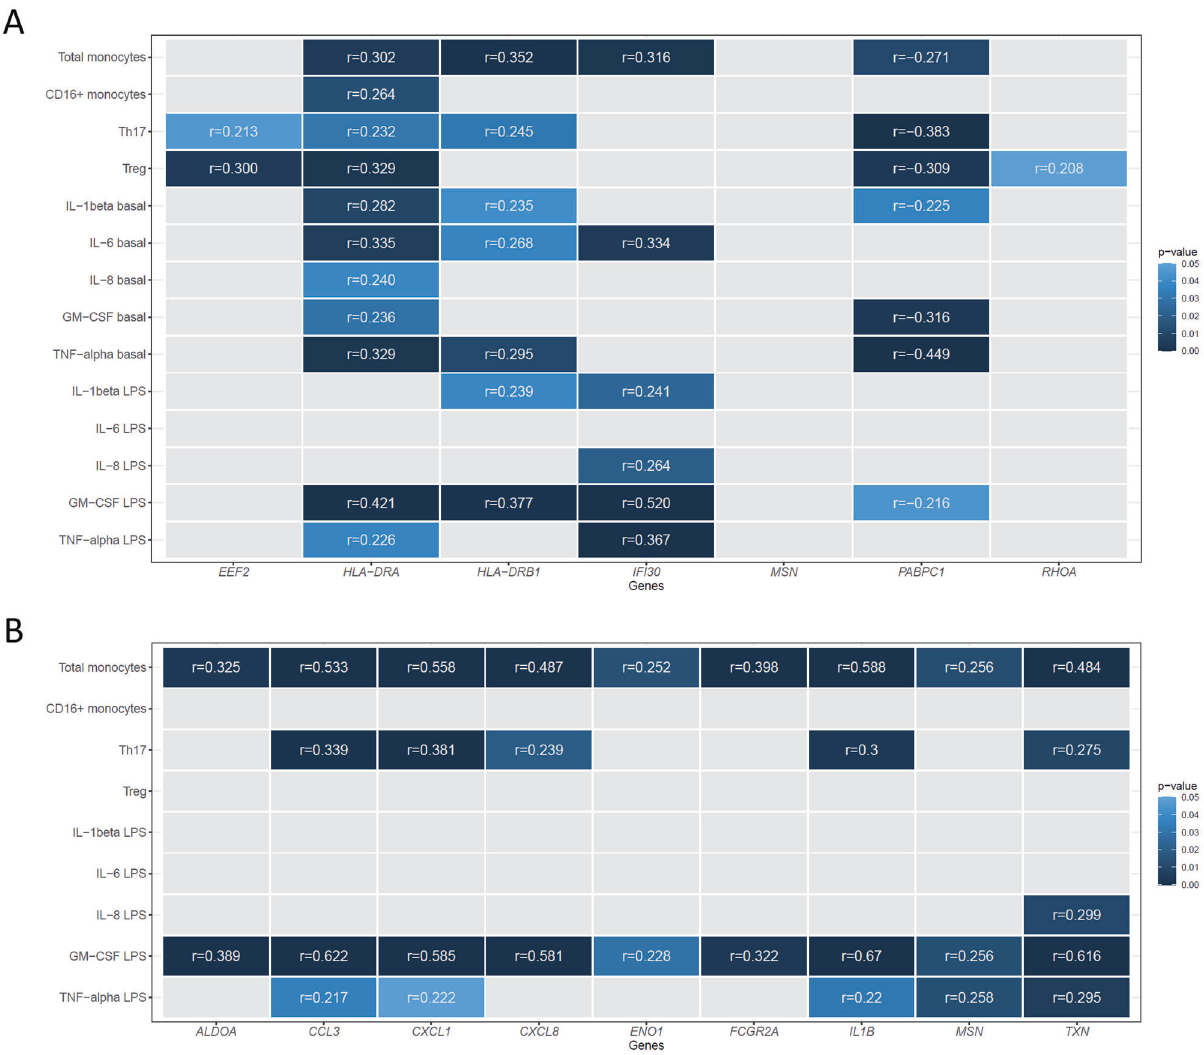
Fig. 4 Correlations between gene expression and immune parameters. The heatmap shows the correlation between the expression levels of the genes assessed in basal conditions ( A ) and after LPS stimulation ( B ) with the immune parameters that were previously reported to be altered in our cohort of OCD patients (percentage of total monocytes and proin fl ammatory CD16 + monocytes, percentage of T helper 17 (Th17) and regulatory T cells (Treg), and cytokine production in primary cultures of monocytes under both conditions). Pearson correlations were computed for pairs of continuous variables. Only signi fi cant correlations ( p < 0.05) are